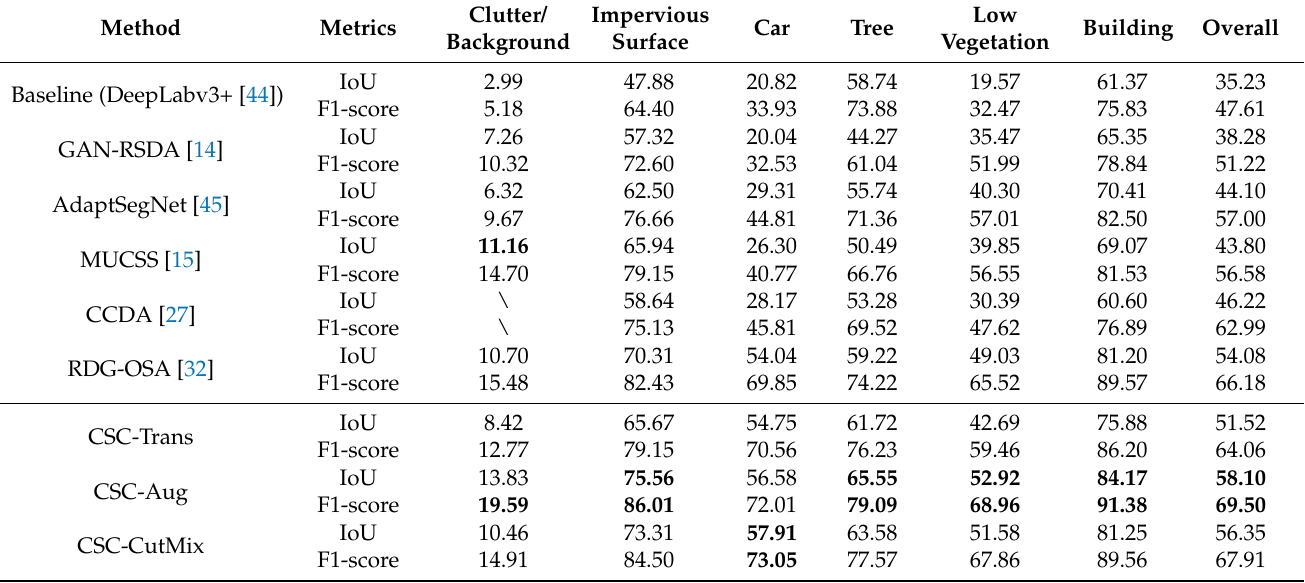
Table 2. Quantitative results (%) of cross-domain semantic segmentation on Potsdam IRRG → Vai- hingen IRRG